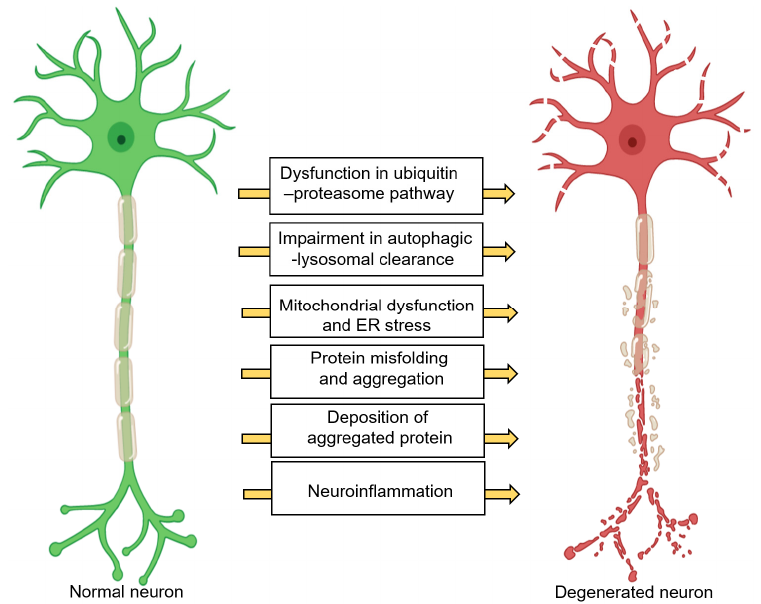
Figure 1. Common neuronal pathways that are changed in different neurodegenerative diseases (1) Dysfunction in the ubiquitin–proteasome pathway increases the intracellular misfolded, damaged, or unneeded protein. (2) Dysfunction in the autophagy–lysosomal pathway triggers the accumulation of pathogenic protein aggregates and damaged mitochondria. (3) Mitochondria dysfunction causes dysfunction and uncontrolled release of reactive oxygen species. (4) ER stress occurs when the homeostatic protein folding and trafficking in the cell is overwhelmed or unbalanced, leading to UPR. (5) Transcellular propagation and seeding of protein aggregates cause disease progression. (6) The aggregation of misfolded proteins contributes to toxicity. (7) A chronic neuroinflammatory state can lead to protein accumulation, ER stress, mitochondria dysfunction, uncontrolled oxidative stress, and axonal transport impairment. Abbreviations- ER: endoplasmic reticulum, UPR: unfolded protein response.